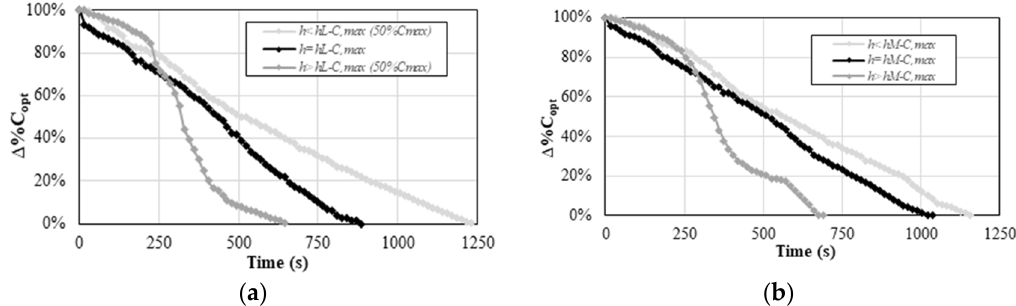
Figure 9. Percentual reduction over time of C opt for different values of h L − C and h M − C respectively in the case of Fresnel lens ( a ) and spherical mirror ( b ) in the presence of secondary optics.